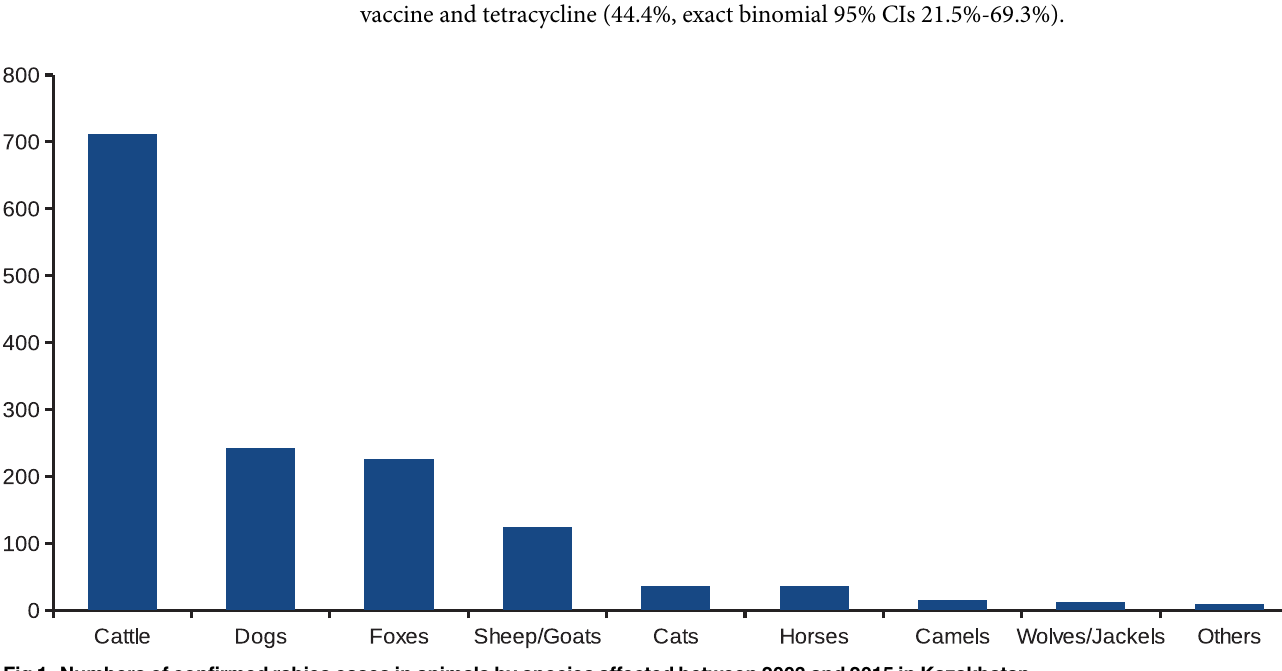
PLOS Neglected Tropical Diseases | DOI:10.1371/journal.pntd.0004889 August 3,